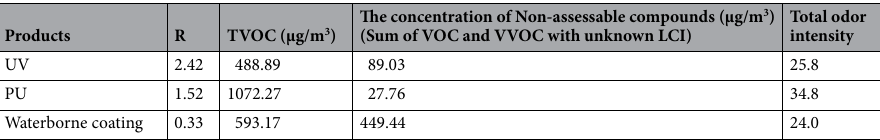
Table 2. Index value of Choerospondias axillaris (Roxb.) Burtt et Hill with different lacquers 7 .